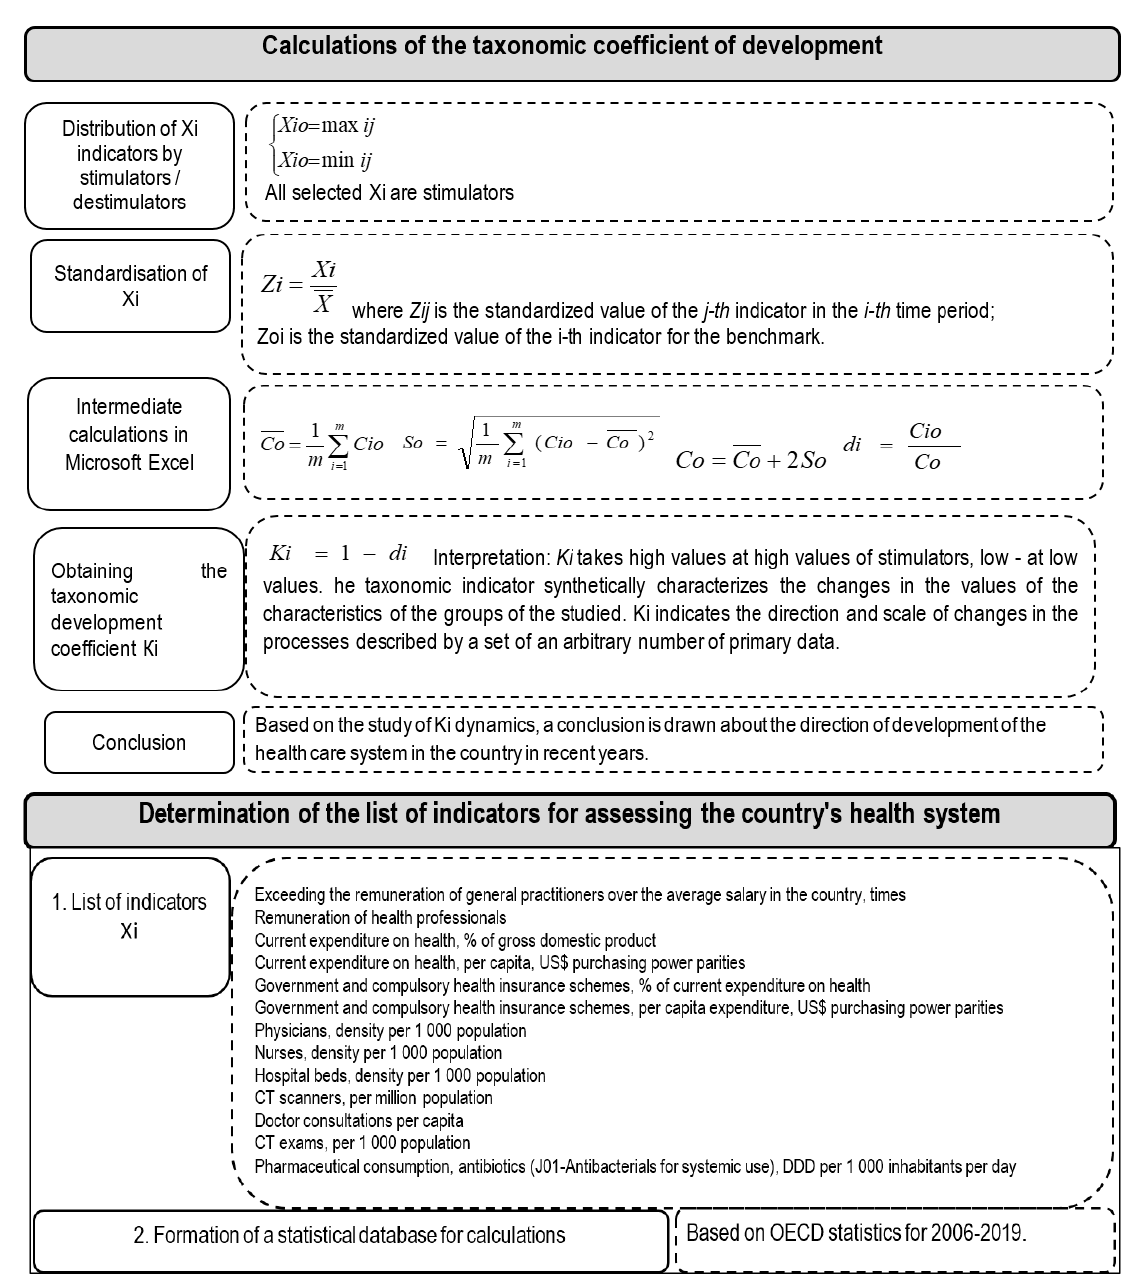
Figure 1. Determination of the taxonomic coefficient of a development health system.